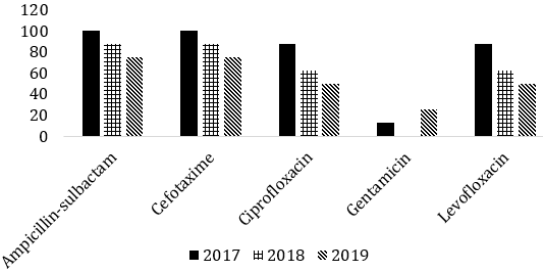
Figure 3. The pattern of antibiotic resistance in